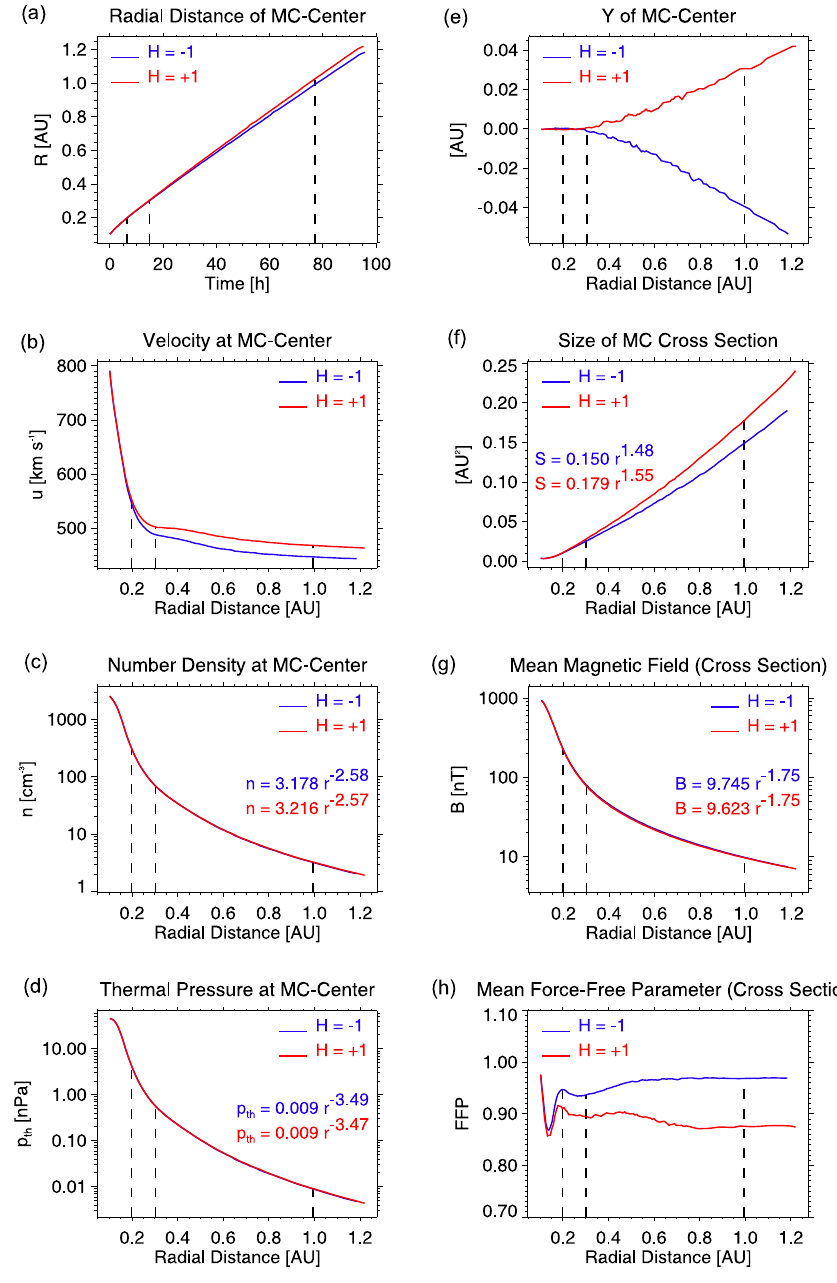
Fig. 9. Radial evolution of parameters at the MC-center and of parameters regarding the whole MC cross section. Graphs for H − e are in blue, and graphs for H + e are in red. Radial fits to simulation data between 0 . 3 − 1 . 0AU are listed as